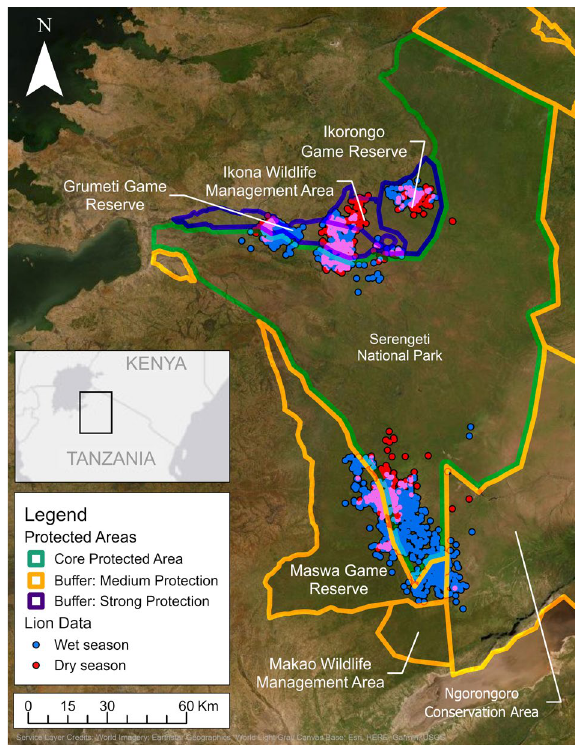
Figure 1. Locations of GPS-collared lions during the wet (November–May) and dry (June–October) seasons in the northern and southern study areas in the protected area complex, with protected area classification (core protected area, buffer protected areas with medium or strong protection) 38 , Serengeti ecosystem, Tanzania, 2018–2019. Map was created using ESRI ArcGIS Pro Version 2.9 using World Imagery basemap, 2022, Esri Inc [https:// www. arcgis. com/ home/ item. html? id= 10df2 279f9 684e4 a9f6a 7f08f ebac2